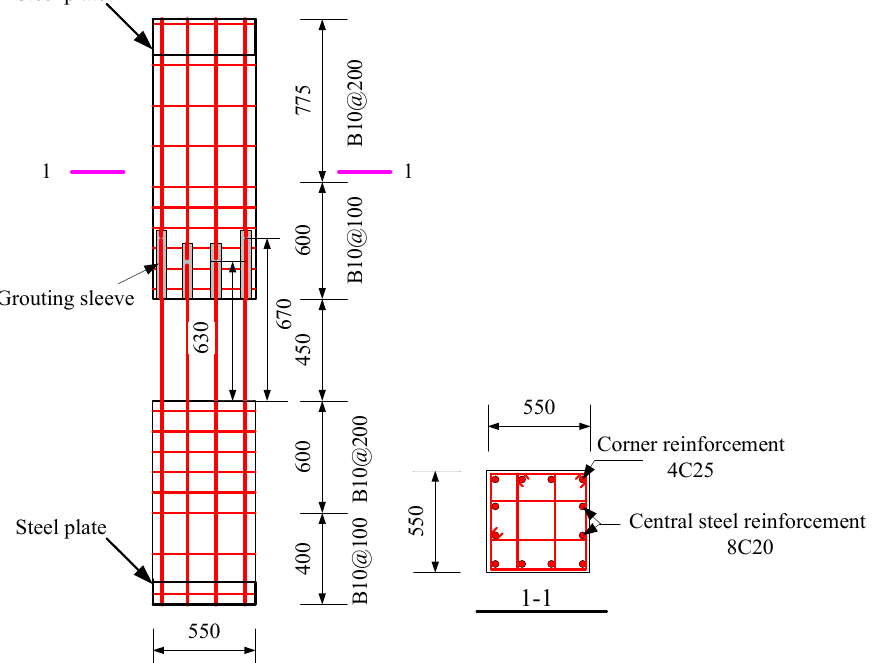
Figure 2. A detailed design of the precast columns (Unit: mm).